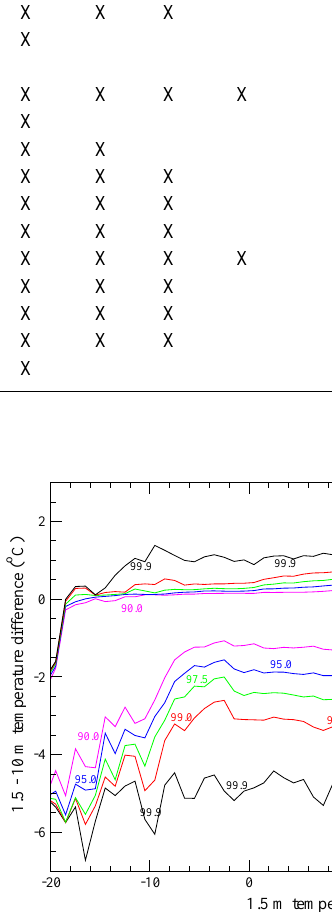
Table 1. List of the 14 RMI’s Automatic Weather Stations performing at least one air temperature record and the associated measurements. AWS Air Temperature Measurement(s) QC Code